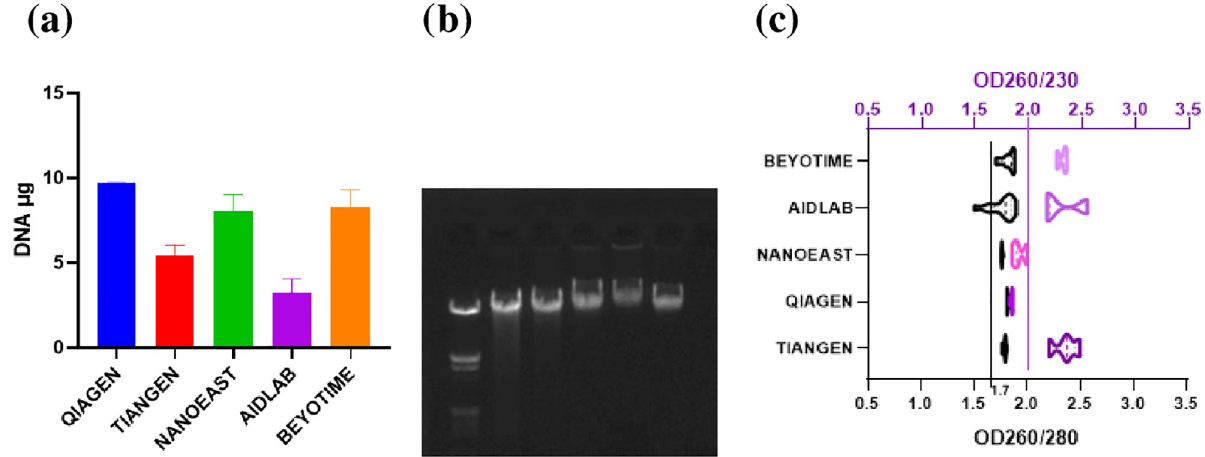
Fig 1. (a) Comparison of DNA extracting capacities of five current methods. (b) DNA electrophoresis of the related samples (Marker, QIAGEN, TIANGEN, NANOEAST, AIDLAB, BEYOTIME). (c) The OD260/OD280 (black) and OD260/OD230 (purple) purity ratios of the related samples.